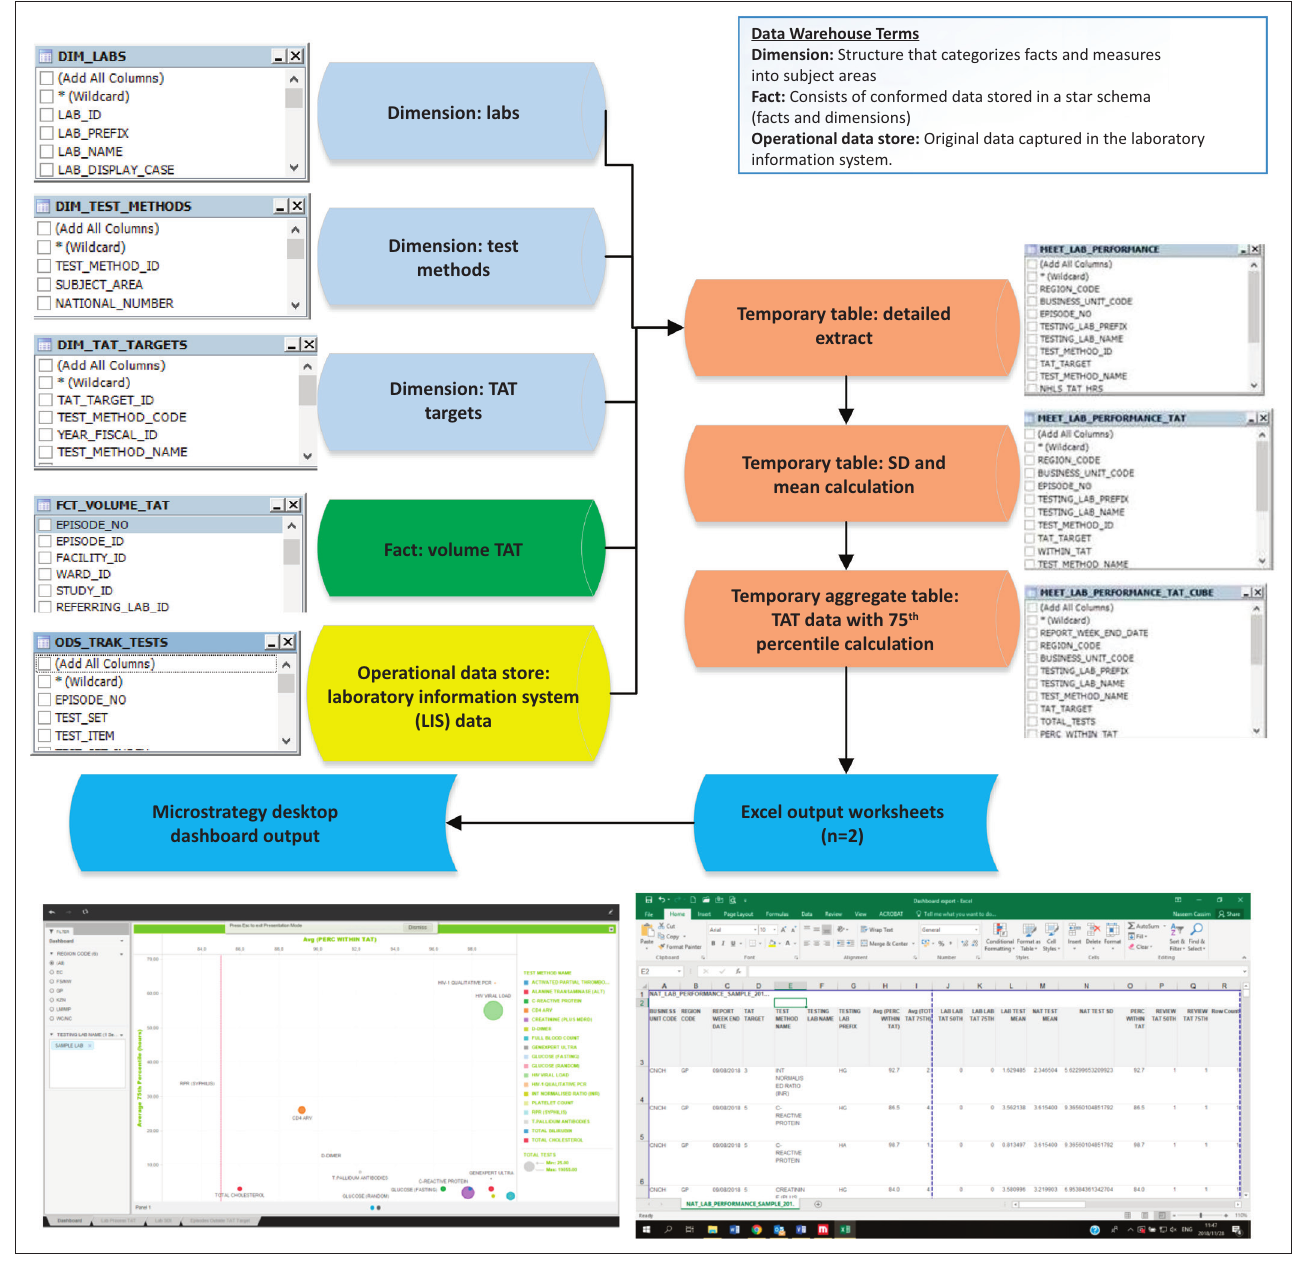
FIGURE 2: Visual representation of data preparation steps to transform and move raw turn-around time data, South Africa, 2018. Data were moved from the Operational Data Store (the laboratory information system) to a production server which consists of facts and dimensions. The production server structures the data by setting sets of data to specific target areas to facilitate final reporting in dashboard format.